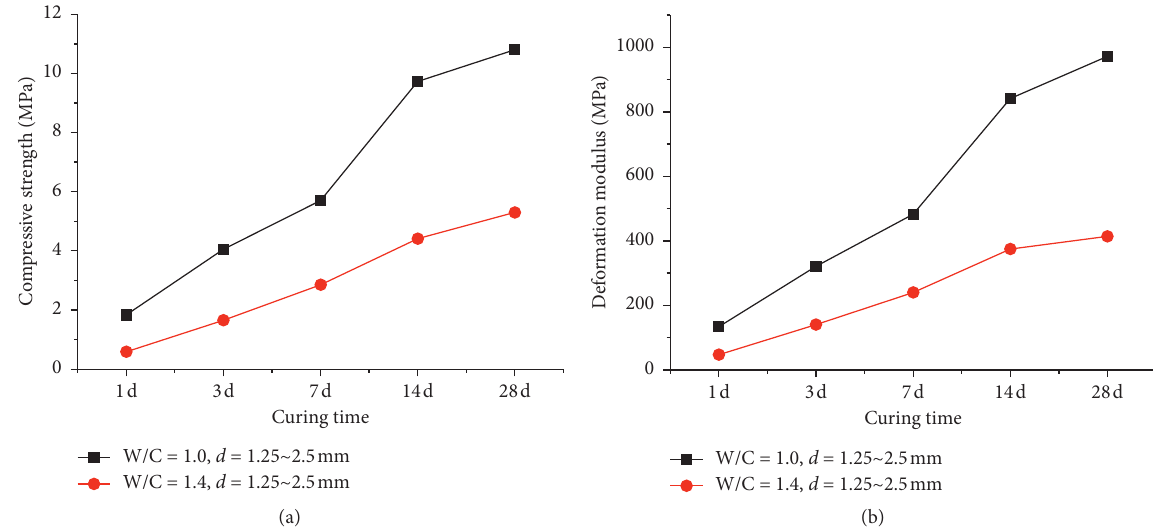
Figure 9: Variation of mechanical performance of the grouted body with curing time. (a) Compressive strength. (b) Deformation modulus.